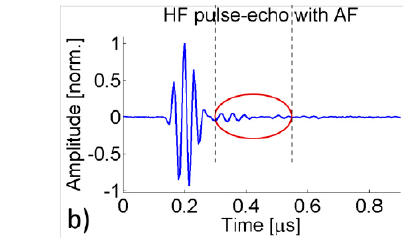
Figure 21. High-frequency pulse–echo response ( a ) without AF layer and ( b ) with AF layer. Reprinted from [190], with the permission of AIP Publishing.